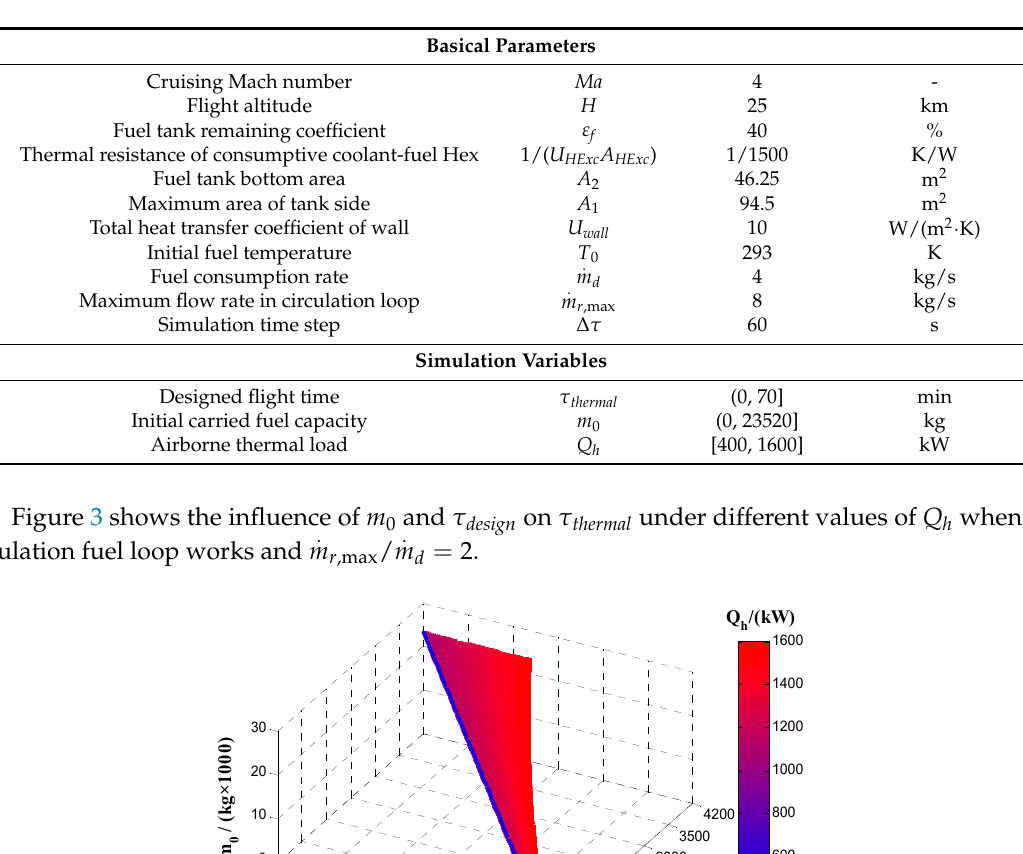
Table 1. Simulation conditions.